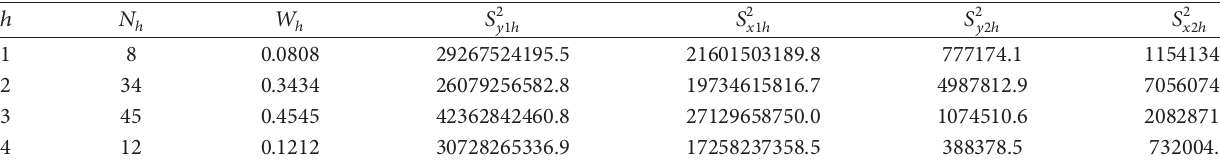
Table 1: Data summary.